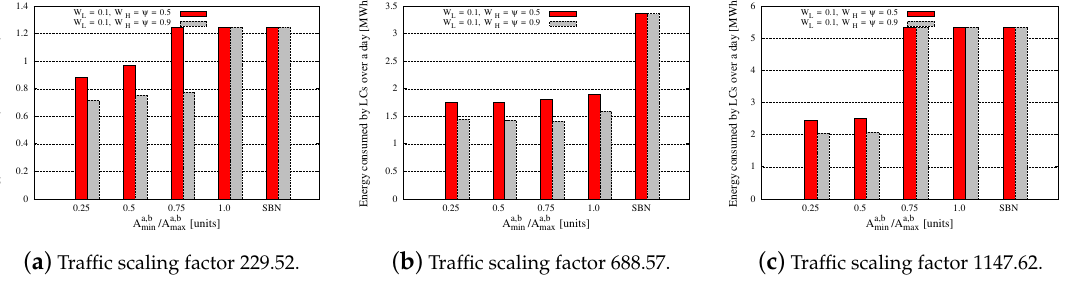
Figure 7. Energy consumption E EWA